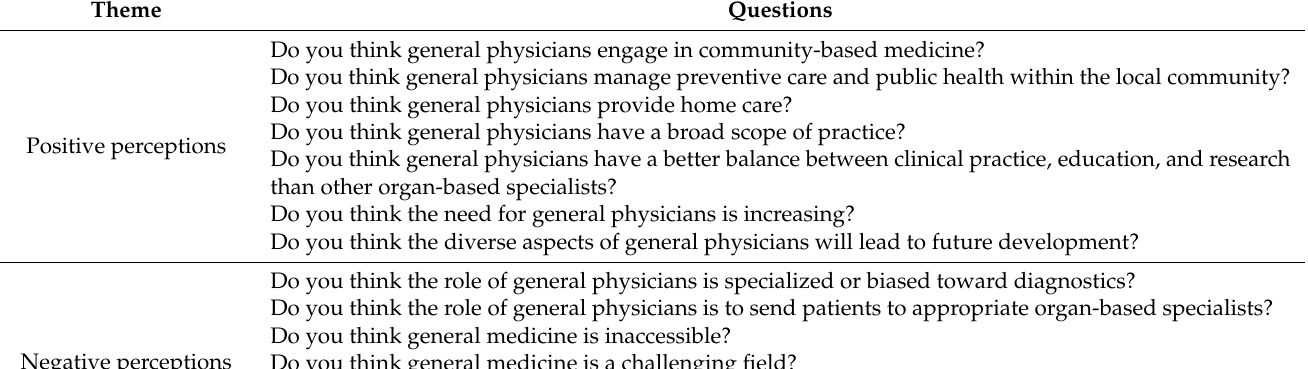
Table 1. Questionnaire to assess medical students’ perceptions of general